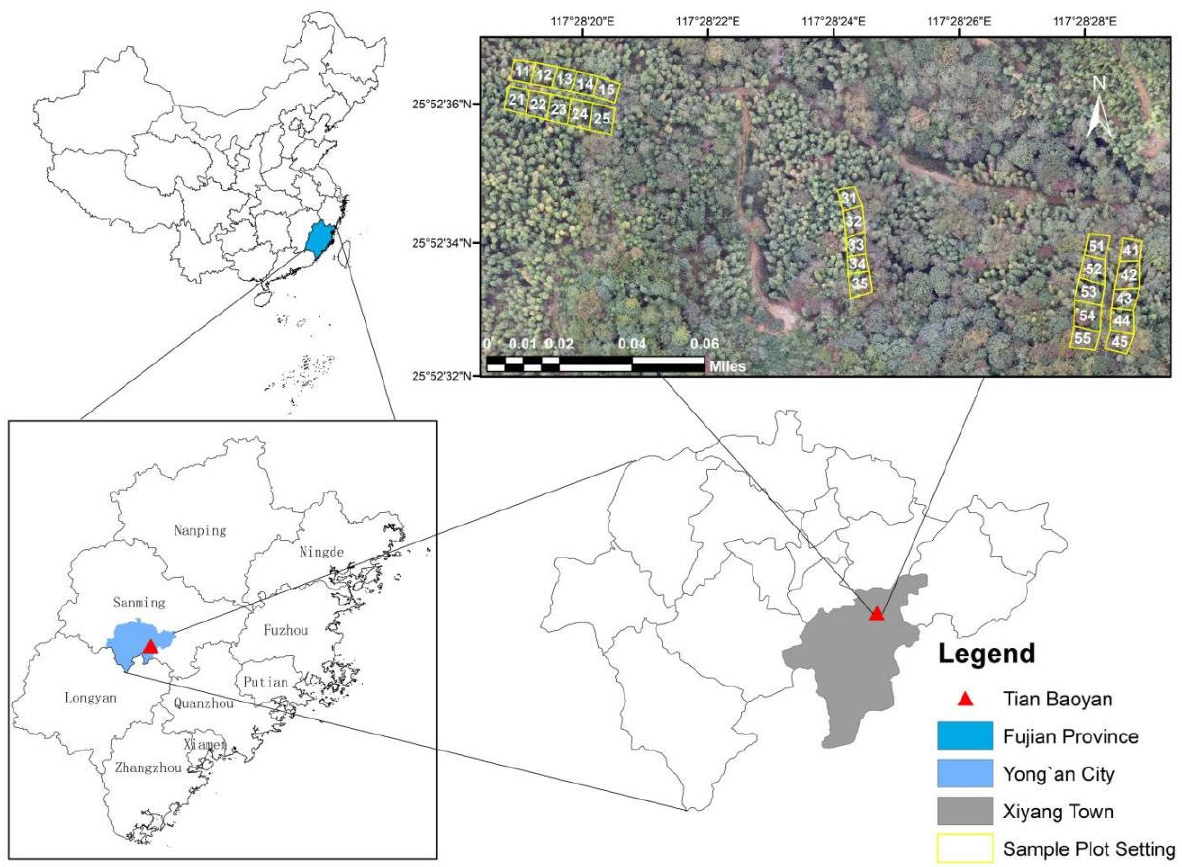
Figure 1. The location and sample setting of the study area (numbers in the sample plot represent the Sites No.).